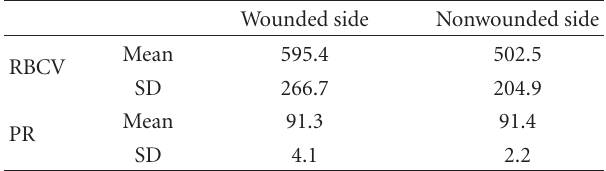
Table 1: The microcirculatory parameters of the wounded- and nonwounded sides. Red blood cell velocity (RBCV) and perfusion rate (PR) values are reported as mean and standard deviation (SD). The unit of RBCV is μ m/s, the unit of PR is